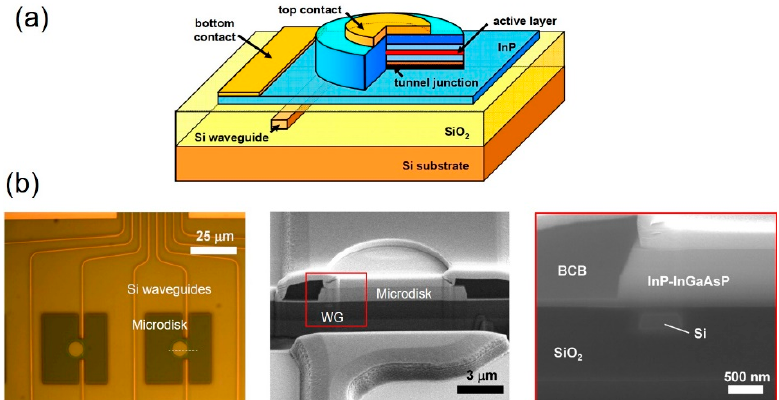
Figure 11. Heterogeneous integration of electrically driven micro- and nano-scale lasers with SOI waveguides. ( a ) Schematic representation of a vertically n - i - p -doped III-V microdisk injection laser heterogeneously integrated with a silicon-on-insulator (SOI) wire waveguide. ( b ) Optical microscope image of integrated InP-based microdisks including InAsP quantum well active layer with Si optical waveguides before contact metallization (left). Focused ion beam cross-sectional view of one of the microdisks in the optical image indicated by the white-dotted line (middle). Magnified SEM image showing a detailed configuration of the integrated InP-InGaAsP microdisk and Si waveguide (right) [47]. Figure reproduced with permission from Optical Society of America.